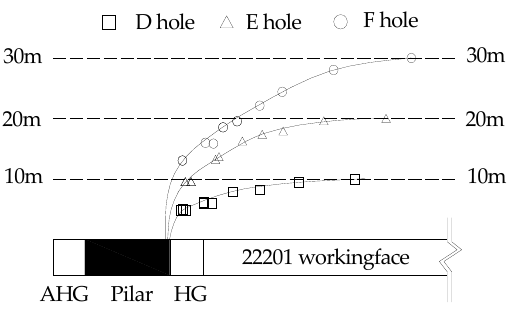
Figure 16. Roof failure schematic diagram along the dip directions.